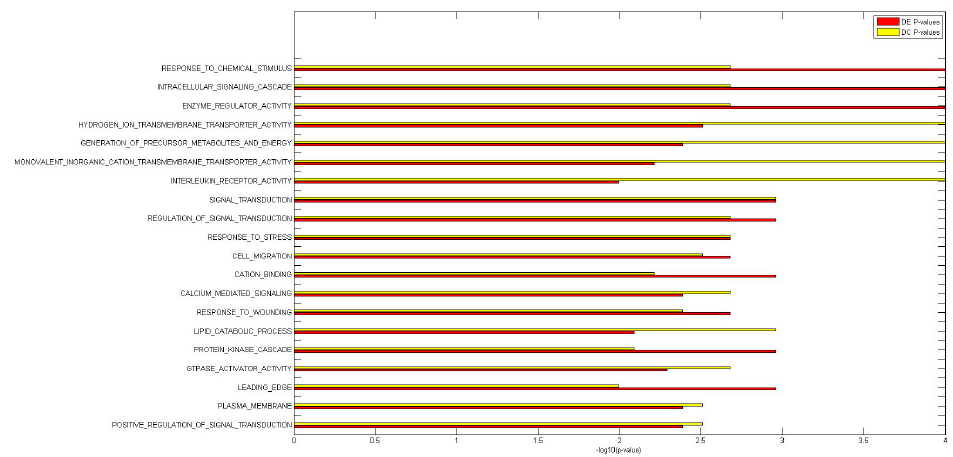
Figure 4. Histogram of the differentially expressed (DE) and differentially co-expressed (DC) − log10 p -value plots for the top 20 DC and DE GO terms.